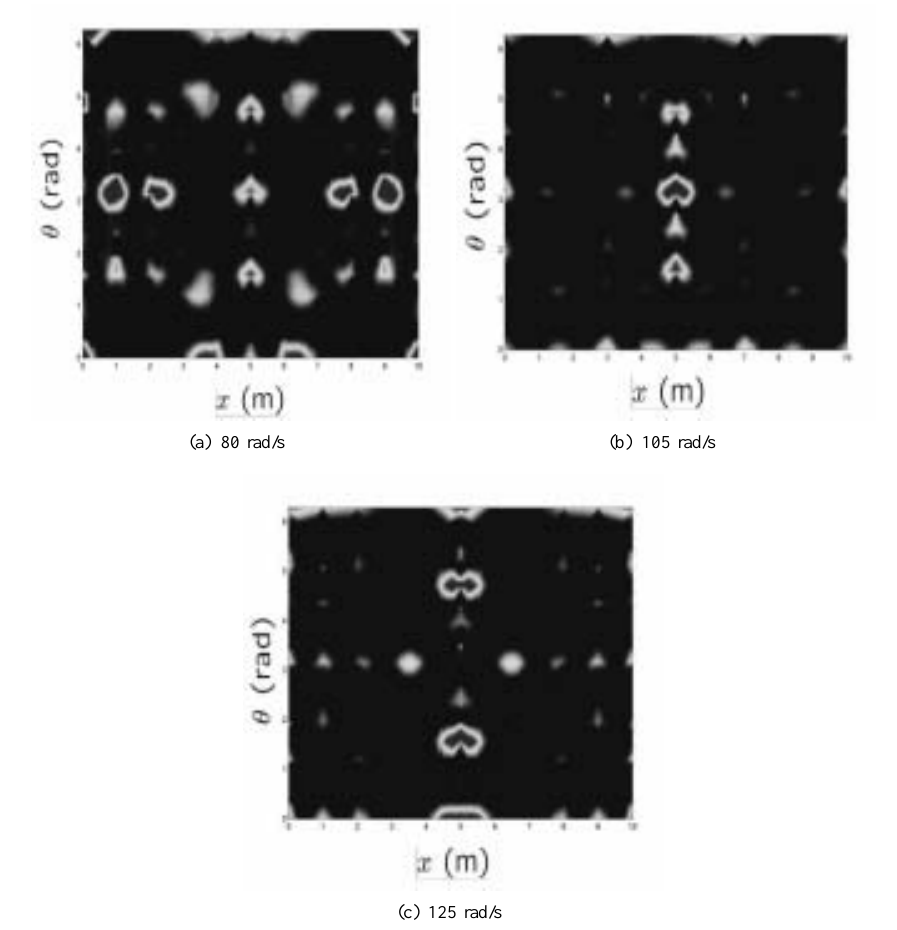
Fig. 9. Harmonic response of first rectangular grid ( a = 0 . 01 m, b = 0 . 01